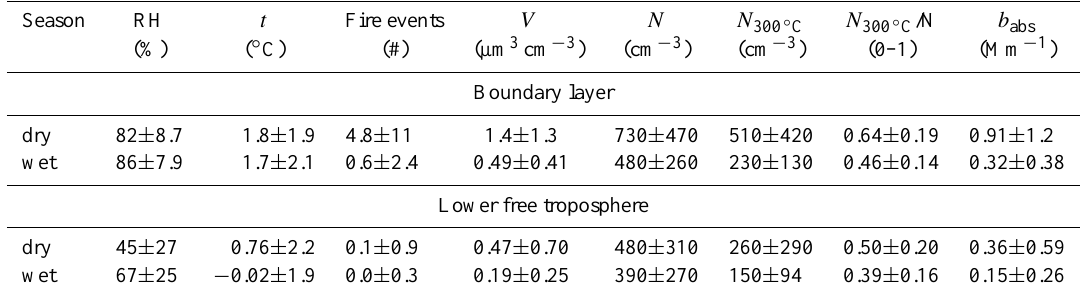
Table 1. Arithmetic mean and standard deviation of observed parameters at Pico Espejo for different seasons and air masses; relative humidity RH (%), temperature t ( ◦ C), number of fire events since the last precipitation event according to the trajectory analysis (#), ambient particle volume concentration V ( D p = 10–470nm) (µm 3 cm − 3 ), ambient aerosol number concentration N (cm − 3 ), refractory particle